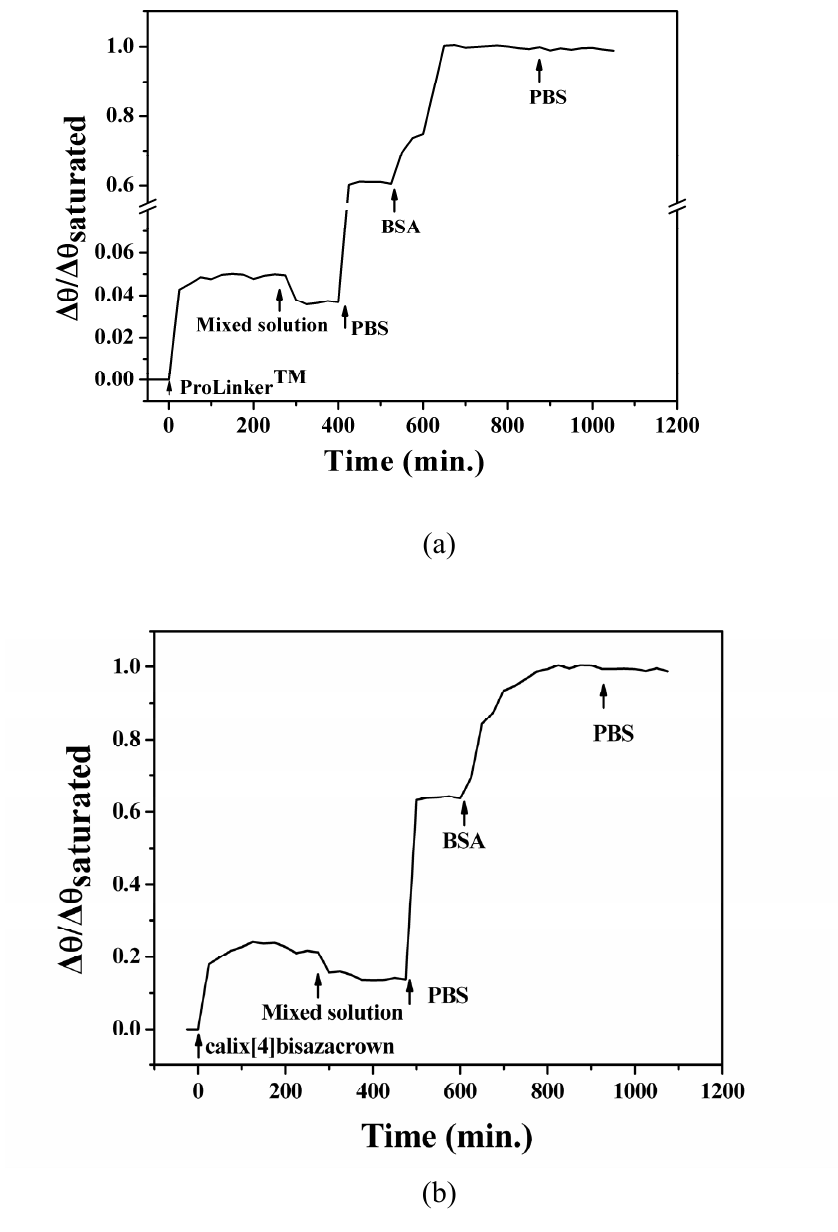
Figure 3. Kinetic sensogram the formation of calix[4]arene SAMs on Au surface and BSA immobilization on (a) ProLinker TM SAM and (b) calix[4]bisazacrown